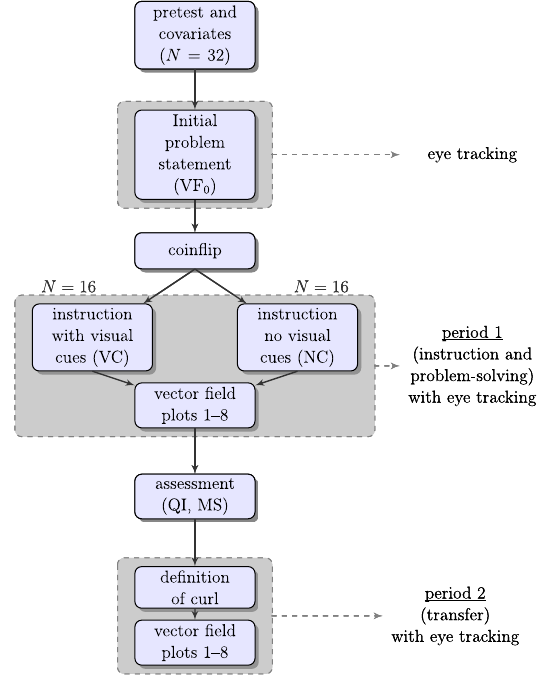
FIG. 2. Study design. The VC or NC condition defines the only contrast between both groups. (Perceived) quality of instruction (QI), (Perceived) mental stress